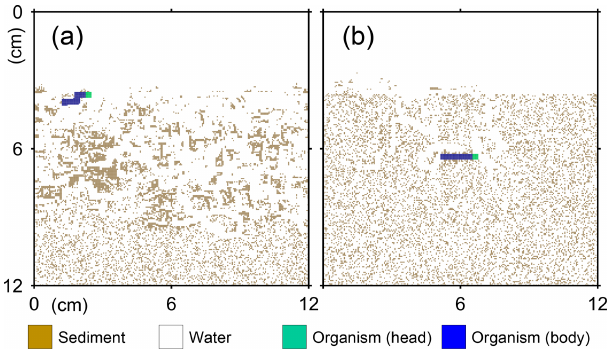
Figure 2. Geometry of burrows after 1-year simulations by LABS with different rules for the preferred direction of organism move- ment. In panel (a) , the preferred direction is where more labile or- ganic matter exists. In panel (b) , an additional rule is imposed com- pared to panel (a) that organisms with greater gut fullness prefer to move in the direction where more water